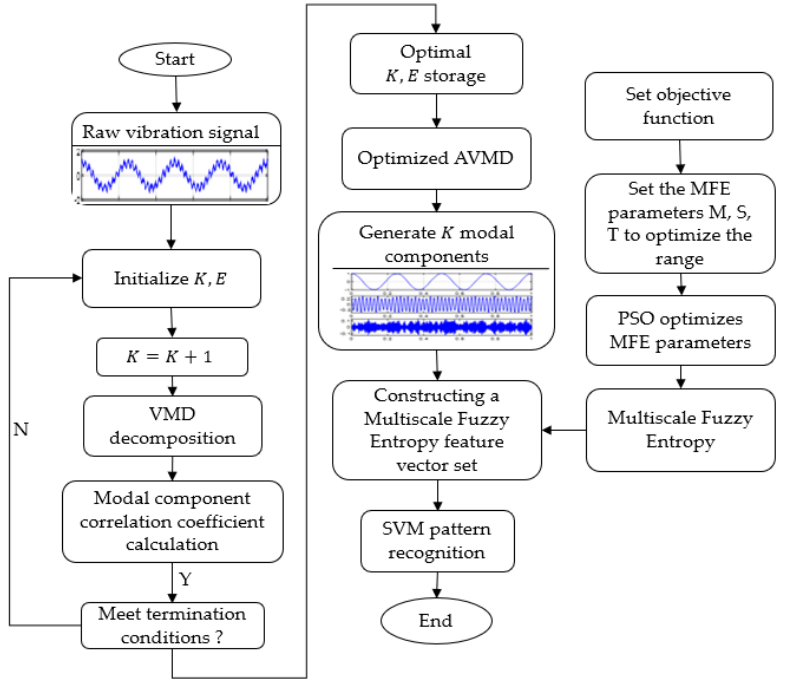
Figure 4. AVMD-based fault diagnosis flow chart.